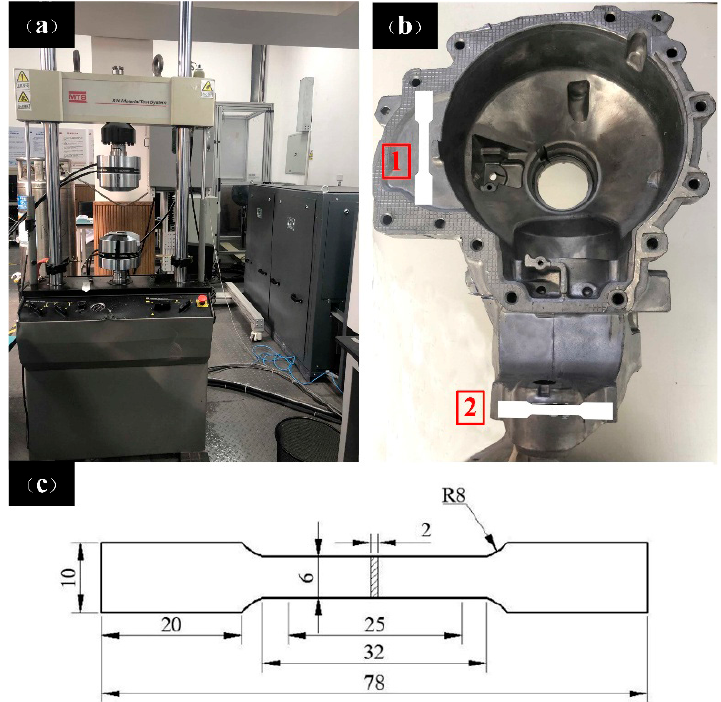
Figure 1. ( a ) MTS810 material testing system, ( b ) Sampling position of tensile specimen, (1) thin- walled area, (2) thick-walled area, ( c ) Size of uniaxial tensile.